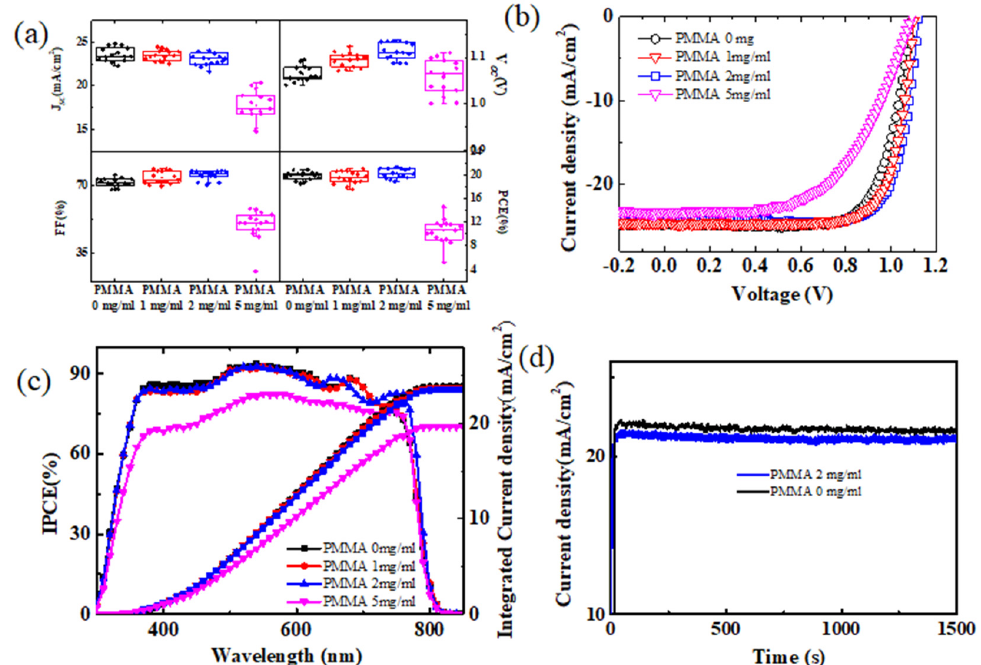
Figure 3. ( a ) Comparison of PSCs’ performance parameters, as follows: short-circuit current density ( J SC ), open-circuit voltage ( V OC ), fill factor (FF), and power convention efficiency (PCE). All results are based on 15 devices under the same working conditions. ( b ) The JV curves of the best devices with different PMMA doping concentrations from 0 mg/mL to 5 mg/mL, and ( c ) incident photon-to-electron conversion efficiency (IPCE) curves of the best devices and corresponding integrated current densities, ( d ) the stabilized current density outputs of solar cells with 0 mg/mL and 2 mg/mL PMMA at the maximum power point (MPP).